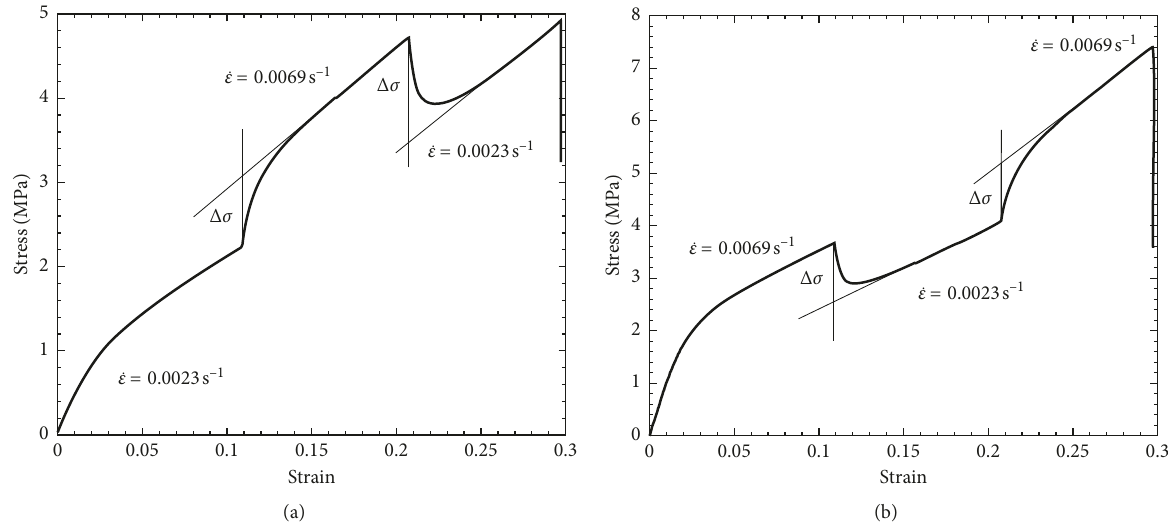
3 s 1 to 6.9 3 s 1 (age of the specimen was 32 days, t 10 10 × × − − − −